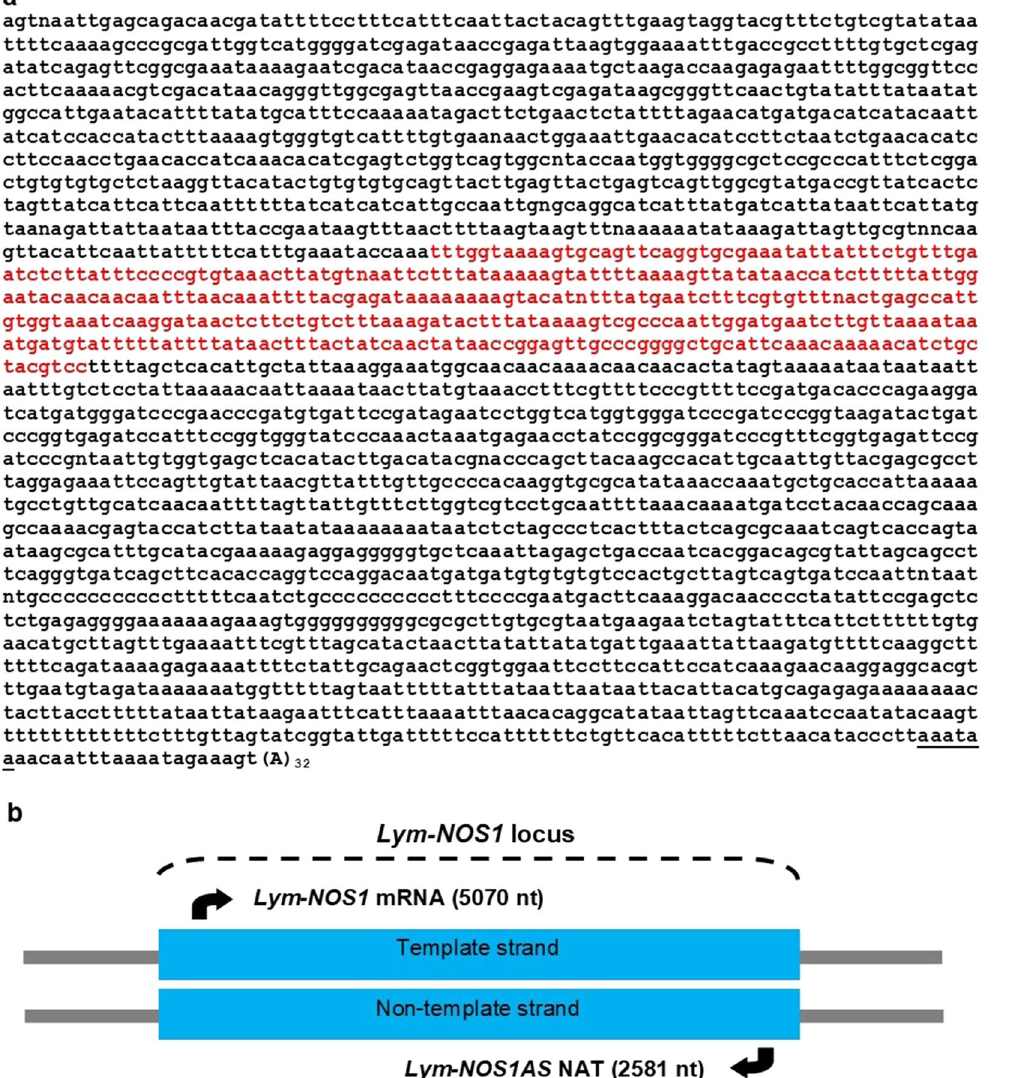
Figure 1. Lym-NOS1AS is a long cis -encoded natural antisense transcript. ( a ) Nucleotide sequence of Lym- NOS1AS NAT (accession number MW300420). The antisense region (shown in red) is complementary to Lym- NOS1 mRNA (accession number AF012531). A putative polyadenylation signal is underlined. ( b ) A schematic diagram showing that Lym-NOS1AS is transcribed from the non-template strand of the Lym-NOS1